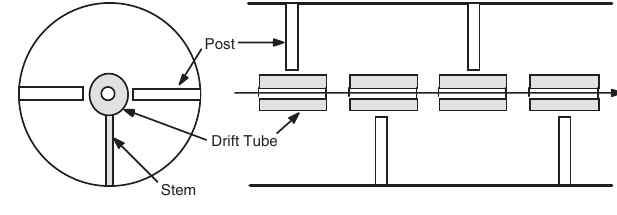
FIG. 1. Postcouplers inside a DTL cavity.